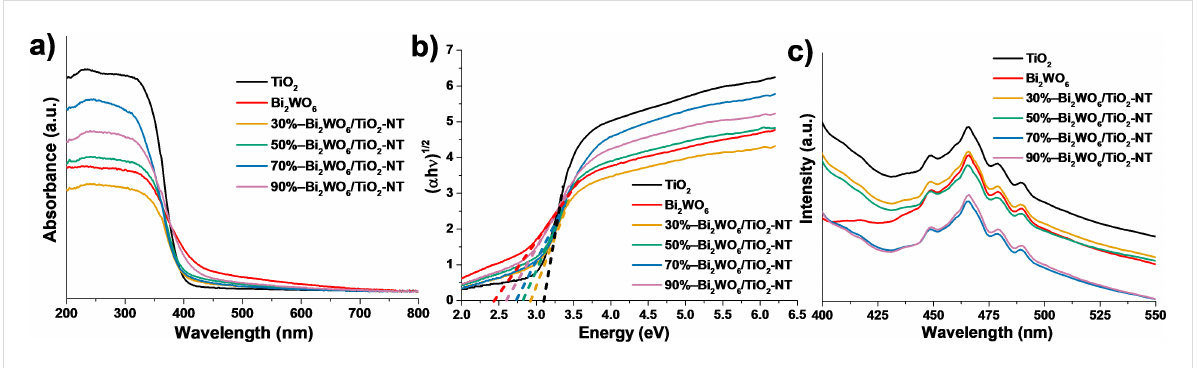
Figure 9: (a) UV–vis DRS, (b) bandgaps determined by the intercept on the x -axis of the respective Tauc plots, and (c) PL emission spectra under the excitation at 360 nm of the pure TiO 2 -NT sample, pure Bi 2 WO 6 powder sample, and the hierarchical Bi 2 WO 6 /TiO 2 -NT nanocomposites.